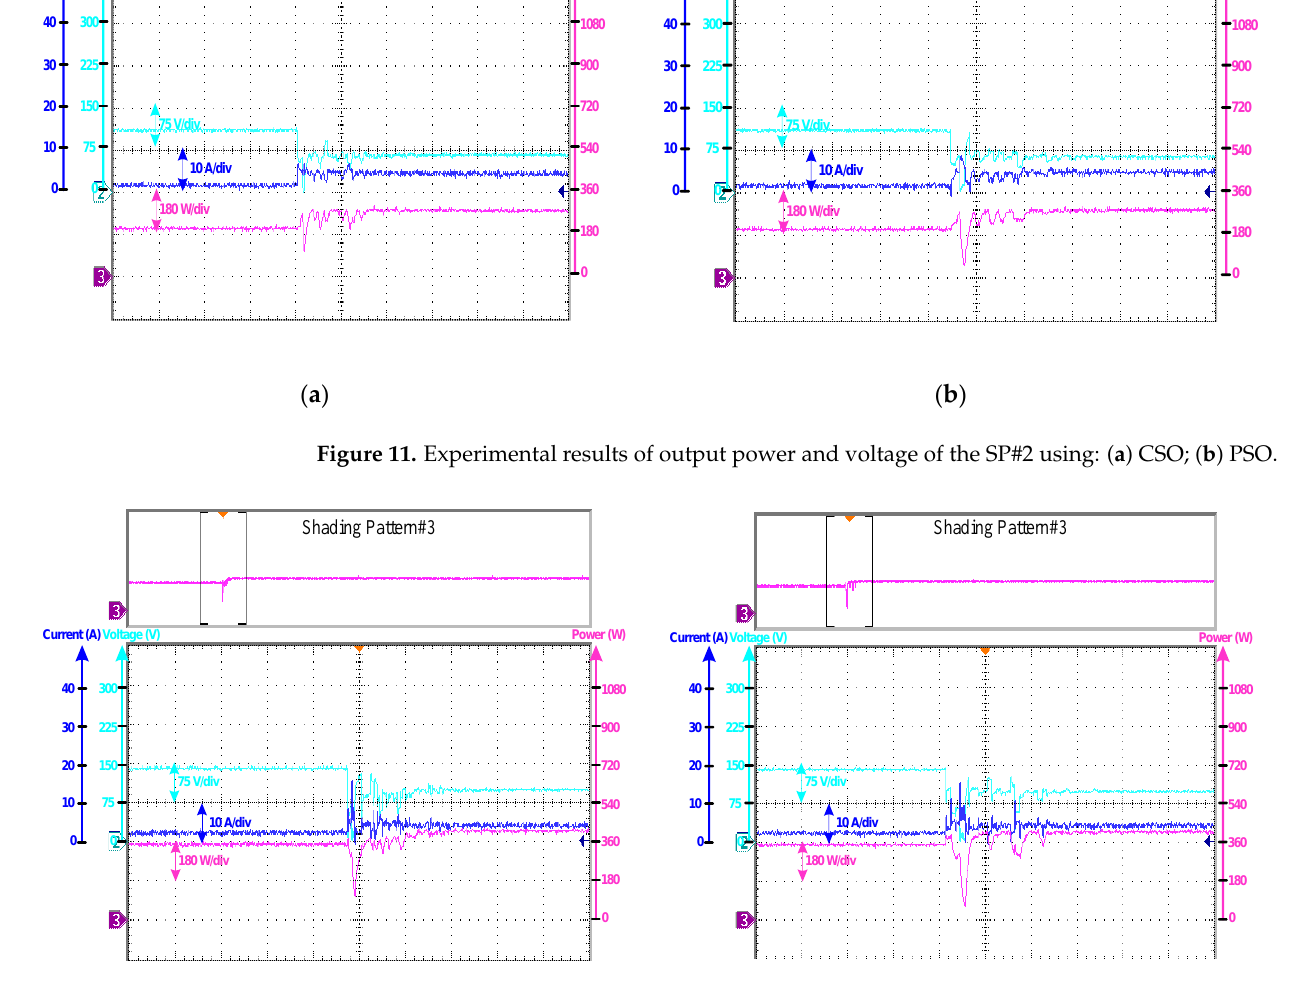
Figure 12. Experimental results of output power and voltage of the SP#3 using: ( a ) CSO; ( b ) PSO.